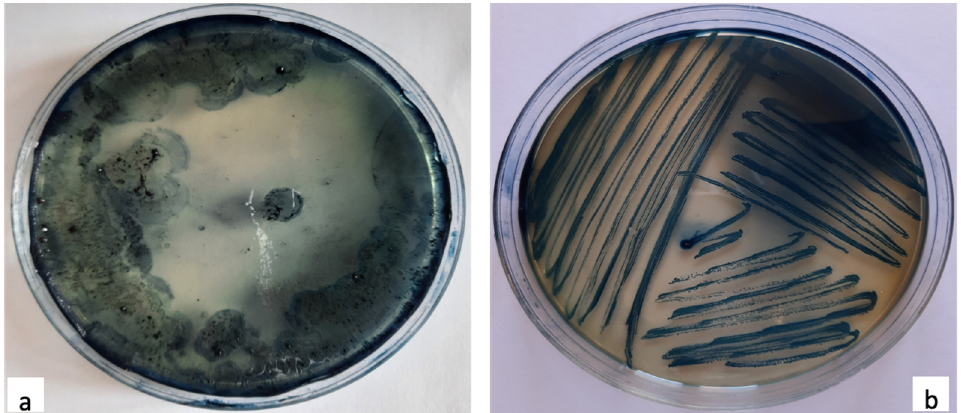
Figure 3. Sudan black B staining for PHB smears identification on petri dishes; presence of black smears for the two positive PHB producers: 1B ( a ) and 2D1 ( b ).